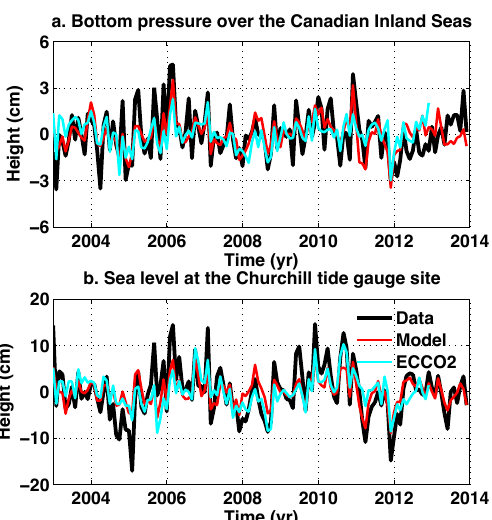
Figure 3. (a) Nonseasonal time series of ocean bottom pressure averaged over the Canadian inland seas from GRACE Release-05 (black), the barotropic model (red), and the ECCO2 solution (cyan). (b) Nonseasonal time series of sea level at Churchill measured by a tide gauge (black), the barotropic model (red), and the ECCO2 solution (cyan). Units are